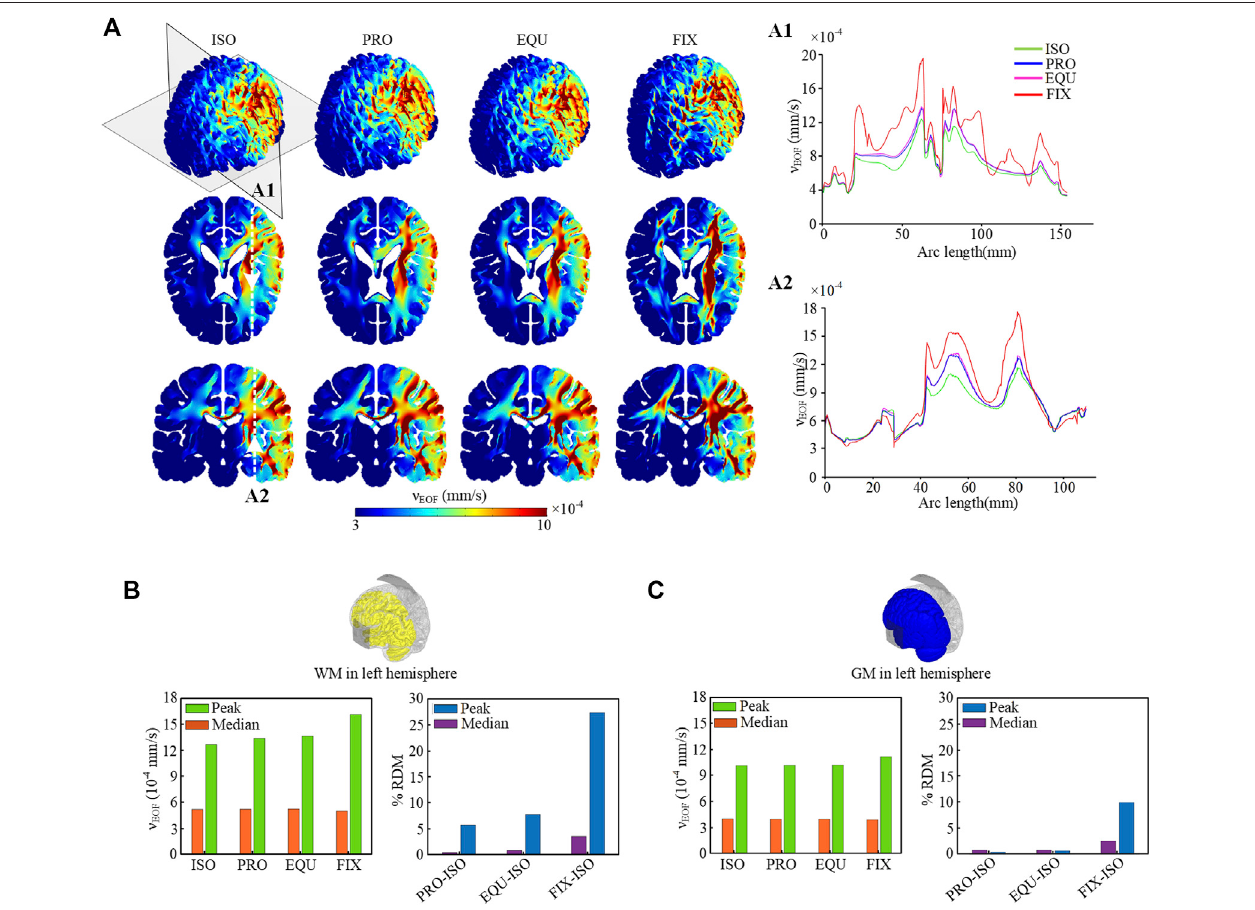
FIGURE5|(A) DistributionofEOFvelocityacrossthebrainandontheaxialandcoronalplanes.TheEOFvelocityalongthecrosslinesintwobrainareasontheaxial (A1) andcoronal (A2) planesinevaluatedquantitatively. (B) PeakandmedianvaluesofEOFforWMinthelefthemisphereforfourmodels,andthepercentARDbetween isotropic and each anisotropic model for peak and median values. (C) Peak and median values of EOF for GM in the left hemisphere and the percent